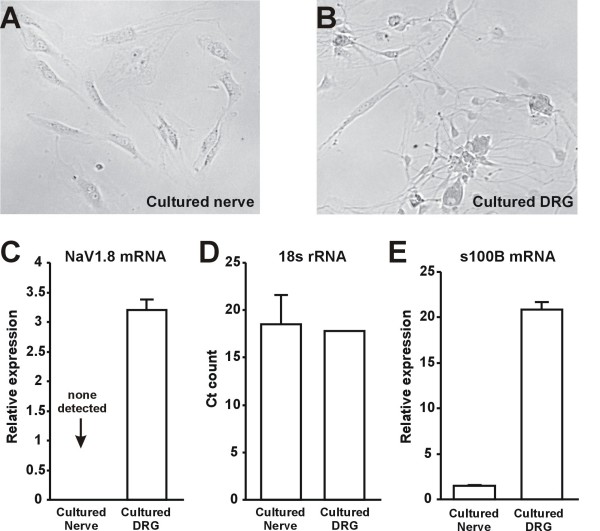
Axonal origin of sciatic nerve NaV1.8 mRNA. A, B: Representative images of cells cultured from the sciatic nerve and dorsal root ganglia. Cells with Schwann- and fibroblast-like morphology were present in both nerve and DRG cultures, whereas neurons were only present in the DRG culture. C: Expression of 18s rRNA in nerve and DRG cultures (n = 3). Expression is given in terms of the absolute cycle count where signal was first detected. D. Expression of NaV1.8 mRNA in nerve and DRG cultures (n = 3). Relative expression was normalized externally against the DRG sample with the lowest NaV1.8 expression and internally against 18s expression rRNA expression. E. Expression of s100B mRNA in nerve and DRG cultures (n = 3). Relative expression was normalized externally against the nerve sample with the lowest s100B expression and internally against 18s expression rRNA expression. Strong expression was observed in both cultures with Ct values of 26–30. However, relative expression was still higher in DRG cultures.